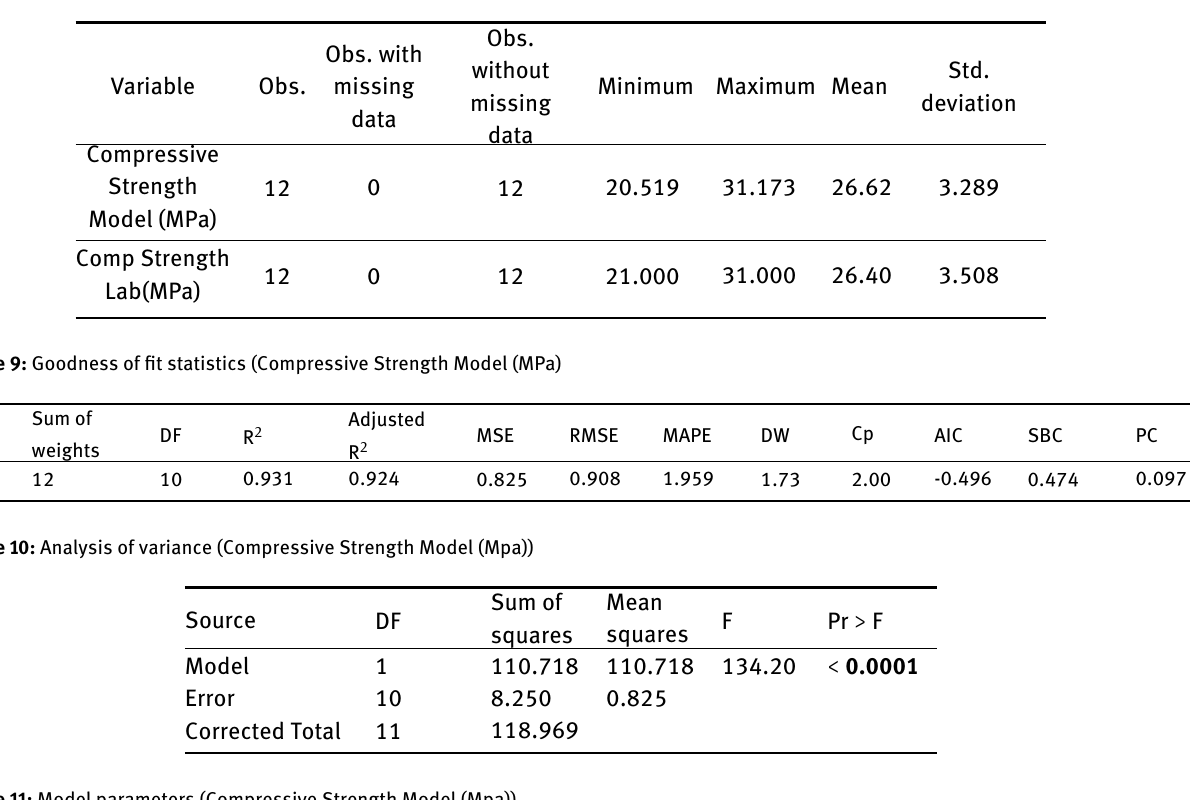
Table 8: Summary statistics